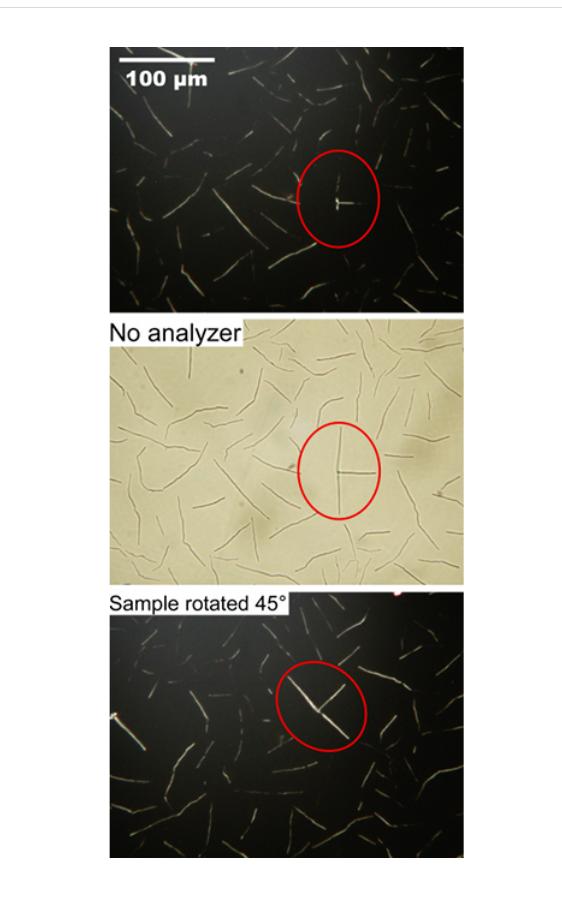
Figure 2: Optical microscopy images of a spin-coated sample with linear structures thick enough to be detected optically. Since their birefringence depends on the relative orientation of the optical axis and the polarizers, we have used a reference area, enclosed in the red oval, for demonstrating the uniform, planar alignment of the director in the linear structures. The upper and lower images were obtained with crossed polarizers while the middle one was taken without the analyzer to show the complete sample morphology.